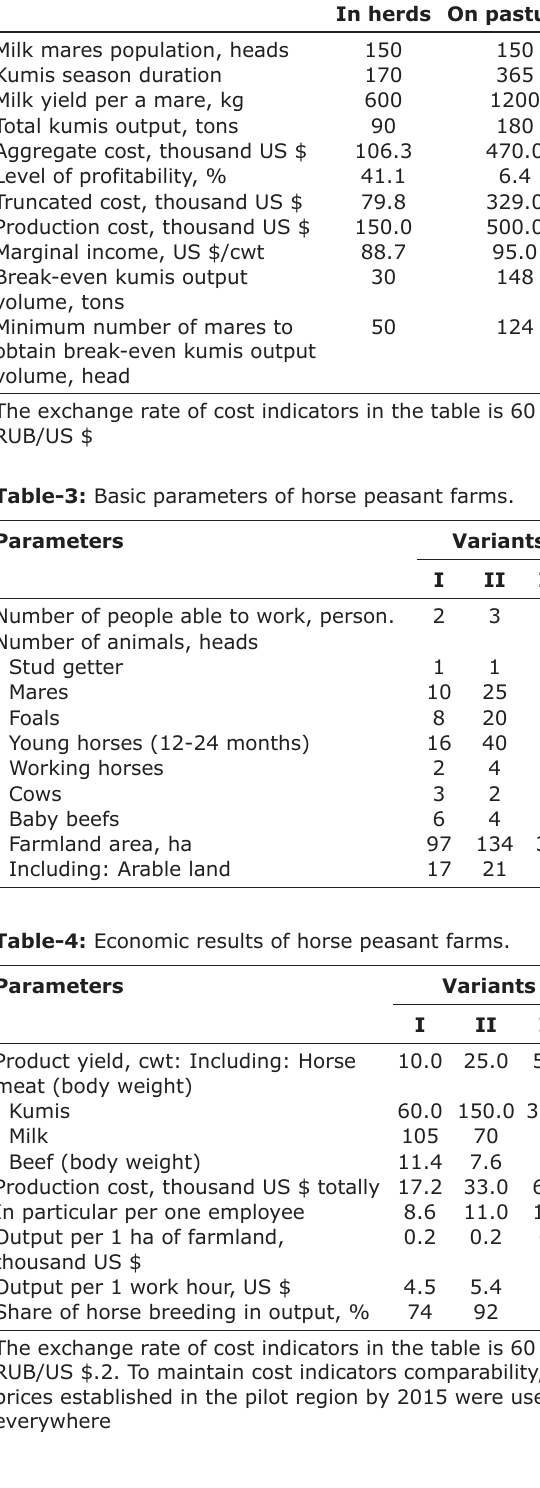
Table-2: Main economic indicators on farms with different ways of horse keeping. Indicator